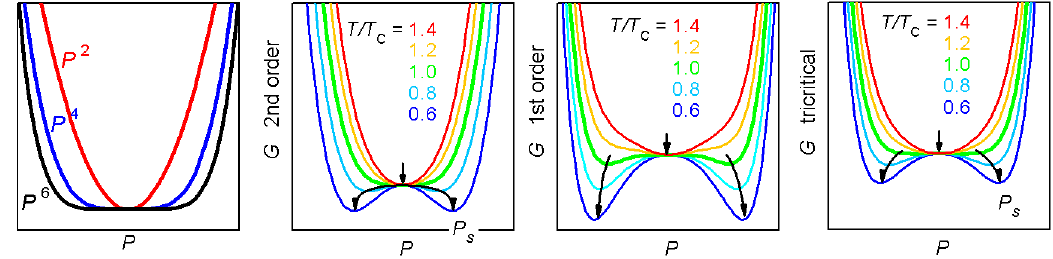
Figure 3. Evolution of G ( P , T ) at T / T C = 0.6, 0.8, 1, 1.2, 1.4 for three choices of the expansion coefficients in Equation (21): α (cid:48) = 1 and β = 0.7, γ = 0 (2nd order); β = − 0.6, γ = 0.7 (1st order); β = − 0.1, γ = 0.7 (near to